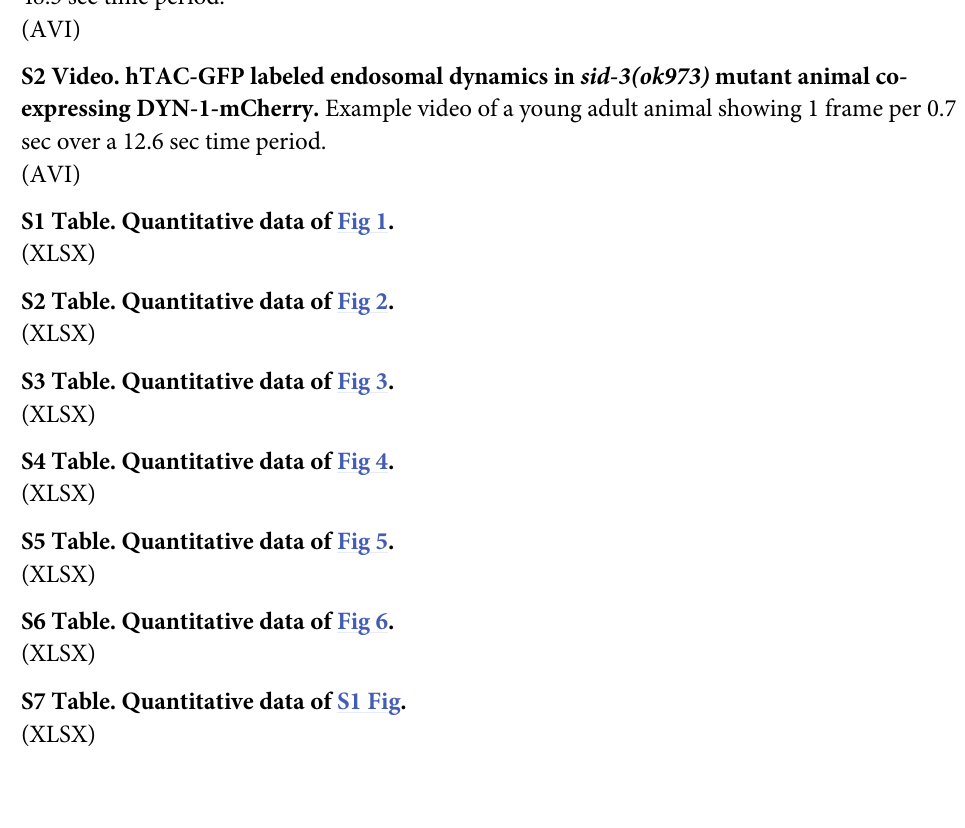
S1 Table. Quantitative data of Fig 1. S2 Table. Quantitative data of Fig 2. S3 Table. Quantitative data of Fig 3. S4 Table. Quantitative data of Fig 4. S5 Table. Quantitative data of Fig 5. S6 Table. Quantitative data of Fig 6. S7 Table. Quantitative data of S1